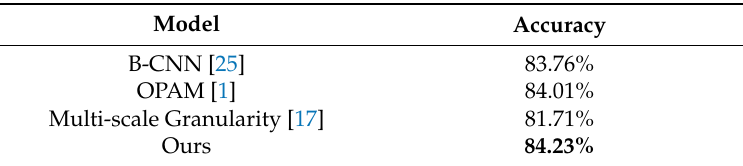
Table 2. Classification accuracy on the FGVC-Aircraft dataset.